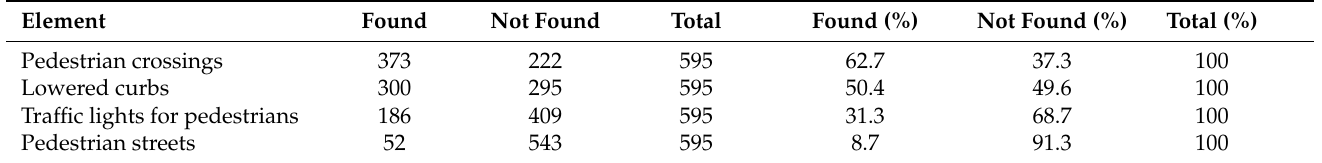
Table 8. Elements found on home–school routes for pedestrians.